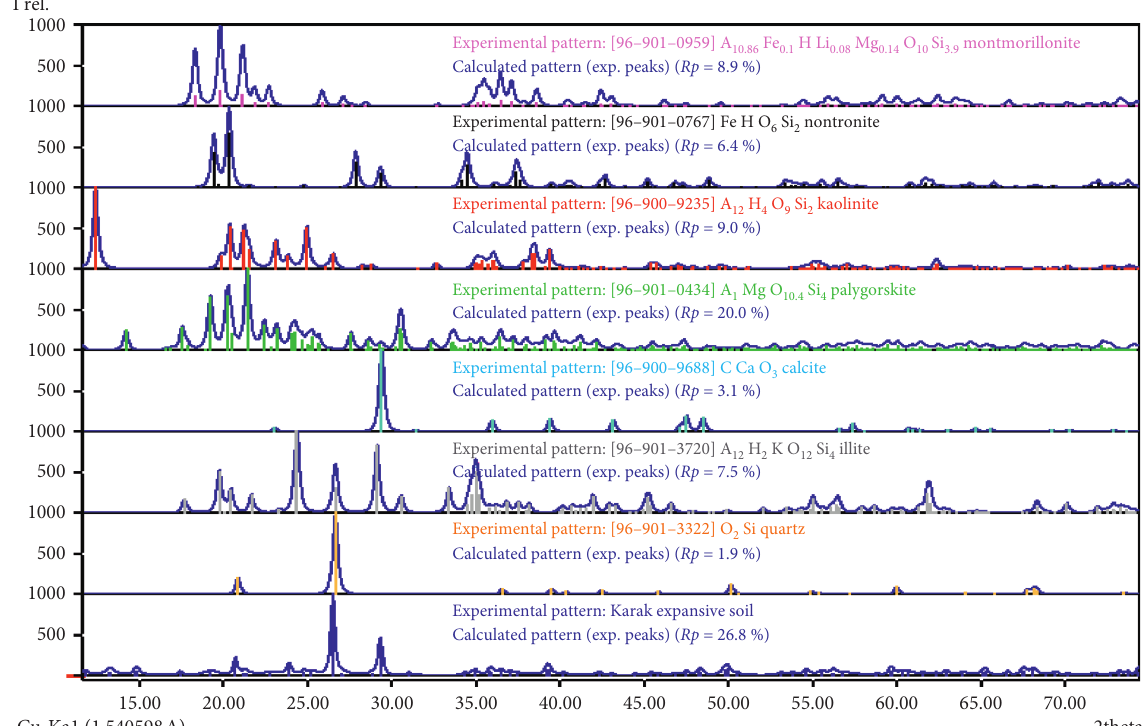
Figure 7: Diffractogram showing the intensity of selected